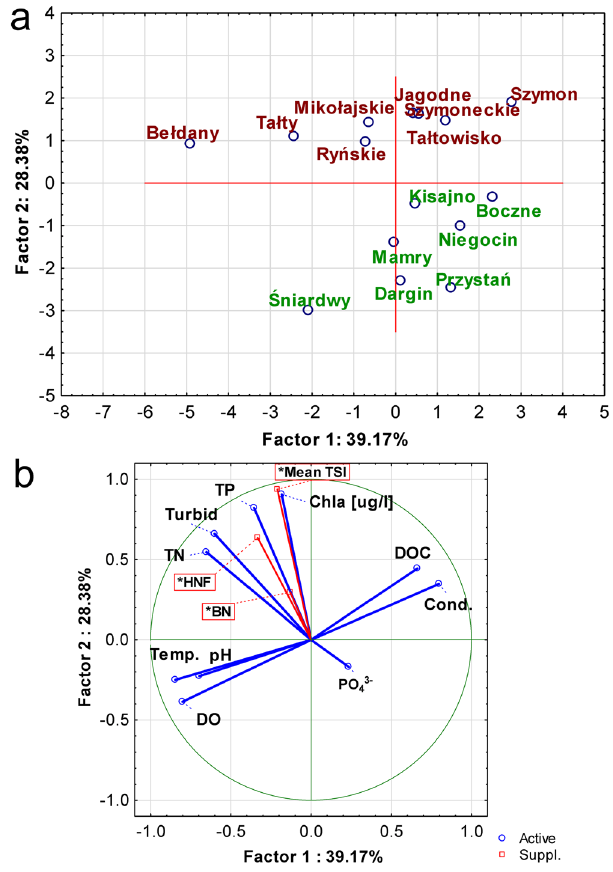
Figure 1. ( a ) PCA-based grouping of lakes according to physicochemical parameters. The lakes marked in red are eutrophic (E), and lakes marked in green are meso-eutrophic (ME). ( b ) Principal component analysis (PCA) results. Projection of variables on the factor planes of PCA analyses of physicochemical variables. The variables in red squares are supplementary and have no influence on the principal components of the analysis. Cond.: conductivity [ µ scm − 2 ], DOC: dissolved organic carbon [mgL − 1 ]. Chl a: chlorophyll a concentration [ µ gL − 1 ], HNF: heterotrophic nanoflagellates [cellmL − 1 ], TN: total nitrogen concentration [ µ gL − 1 ], Turbid: nephelometric turbidity [NTU], Temp.: temperature [°C], DO: dissolved oxygen concentration [mg O 2 L − 1 ], TP: total phosphorus concentration [ µ gL − 1 ], PO 43 − : orthophosphate concentration [ µ gL − 1 ], mean TSI: mean trophic state index, BN: bacteria number [cellmL − 1